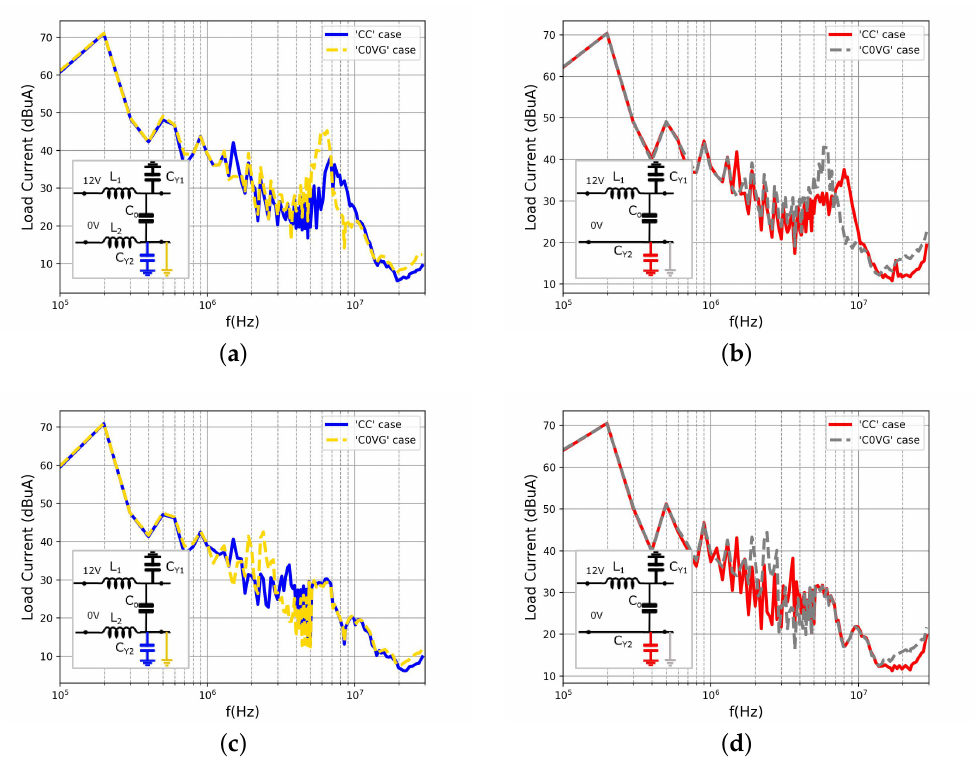
Figure 9. Measured DM output currents for ‘C0VG’ and ‘CC’. ( a ) C y = 10 nF, ‘S’ case. ( b ) C y = 10 nF, ‘AS’ case. ( c ) C y = 50 nF, ‘S’ case. ( d ) C y = 50 nF, ‘AS’